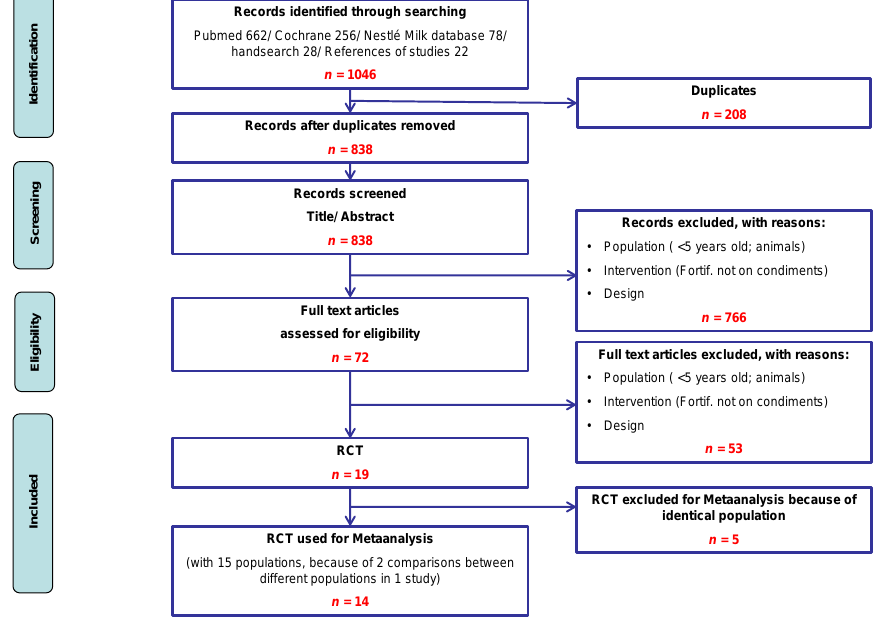
Figure 1. Flow-chart of studies in the review